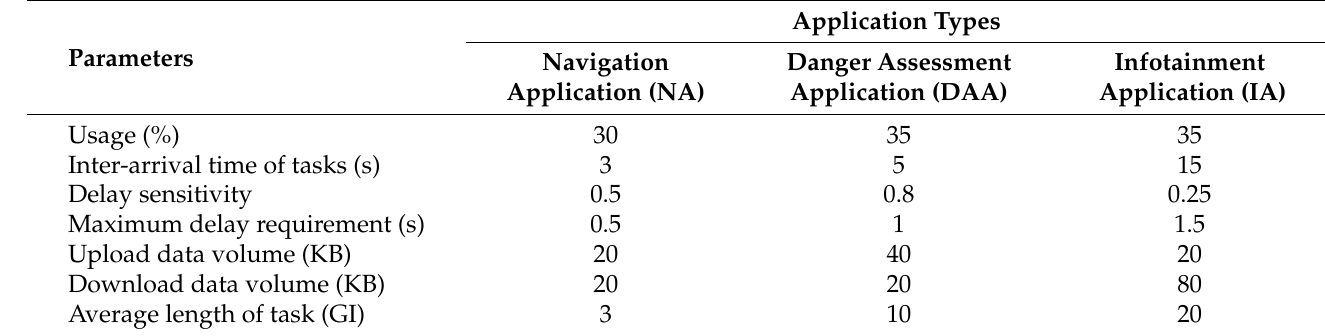
Table 3. Simulation parameters for the three types of applications.